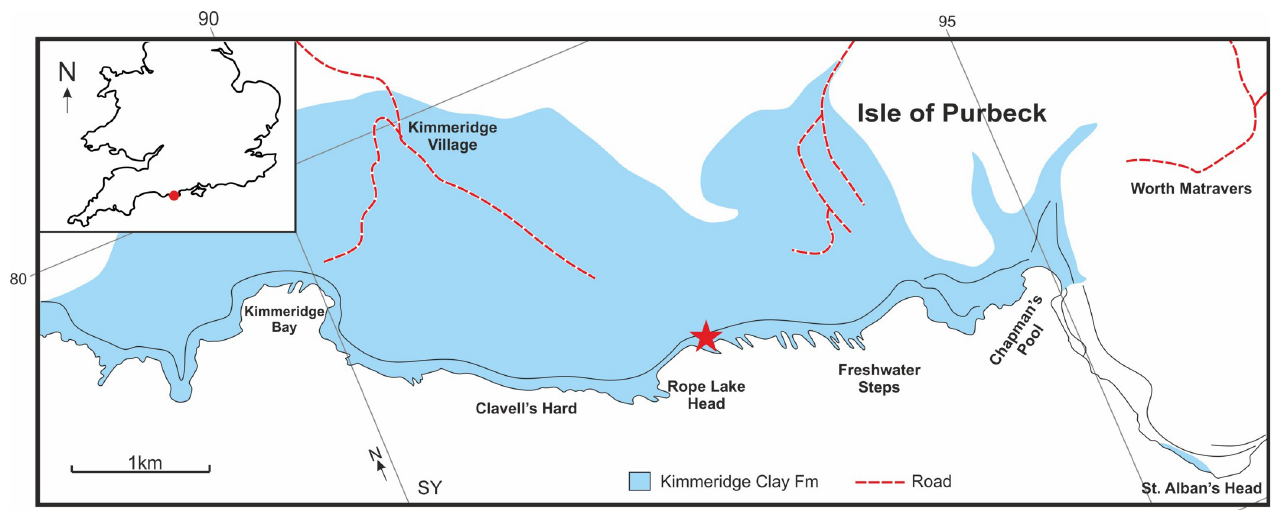
Fig 2. Map showing the Kimmeridge Clay Formation outcrop in Dorset, southern England. The White Stone Band is exposed between Rope Lake Head and Freshwater Steps. Star indicates the locality of MJML K1885. Base map data from Lees et al . [23].